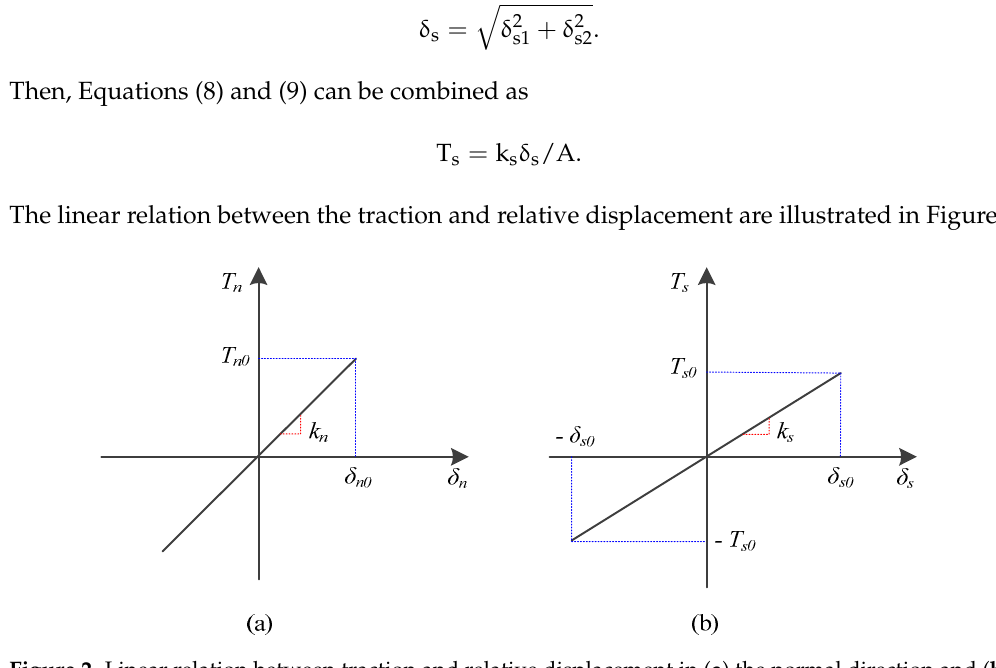
Figure 2. Linear relation between traction and relative displacement in ( a ) the normal direction and ( b ) the shear direction.